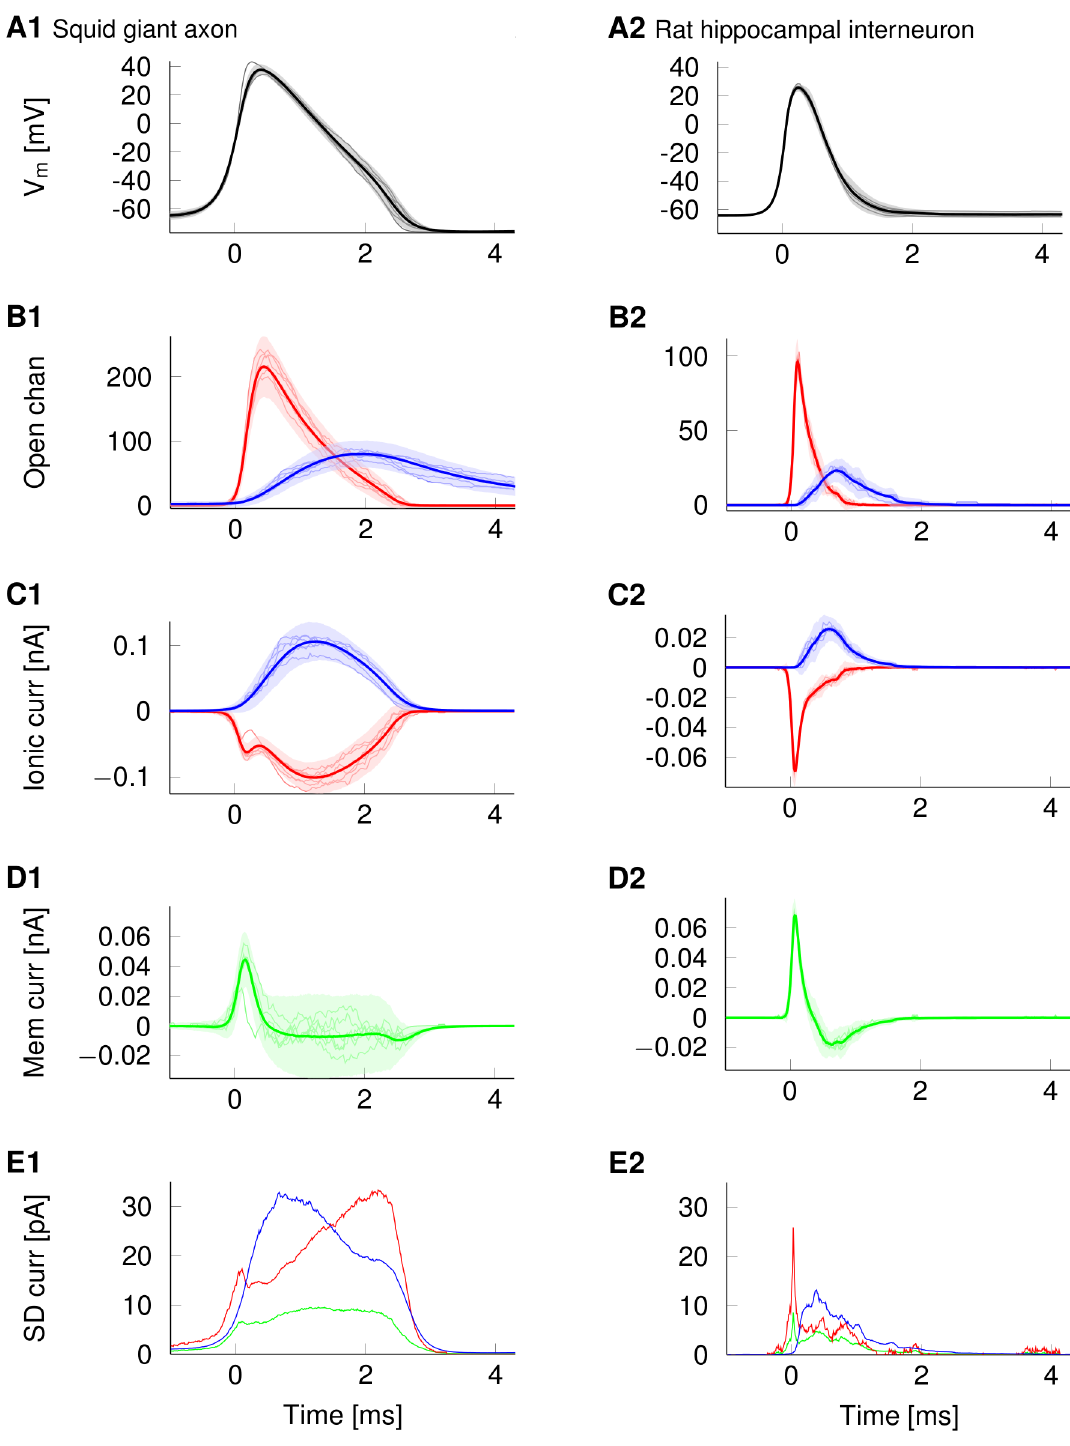
Figure 6. Ion channel and current fluctuations underlie waveform variability. Ion channel and current fluctuations in an AP travelling along 0.2 m m diameter axons. All traces are aligned at the instant when the rising AP crosses half-peak. Data from the squid giant axon model is on the left, while the right plots show data from the rat hippocampal interneuron model. Shaded areas in A–D are the 3 6 SD envelope around the mean curve (dark curve). Light curves in A–D represent a sample of individual traces. (A) Membrane potential waveforms (B) Number of open Na + (red) and K + (blue) channels (C) Current flowing through Na + (red) and K + (blue) channels (D) Net membrane current (sum of Na + , K + and leak) (E) SD of Na + (red), K + (blue) and net membrane (green) currents.